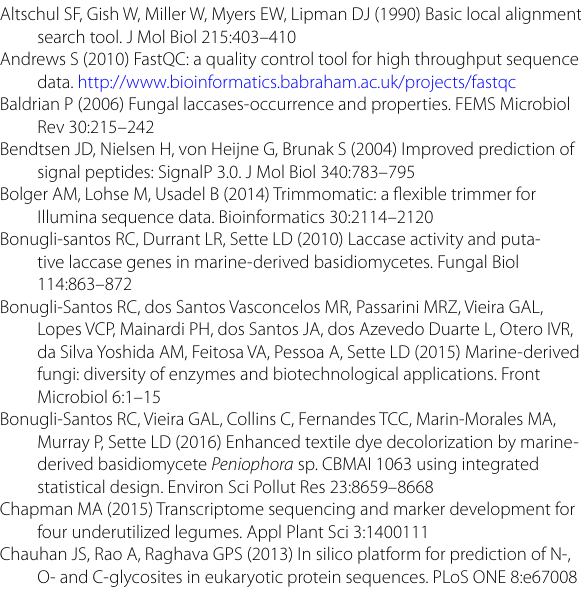
Figure S1. Species distribution of all homologous unigenes. Figure S2. Gene ontology (GO) classification of assembled unigenes (Level 2). GO terms were distributed into three ontologies: molecular functions—blue bars; biological process—red bars; and cellular component—green